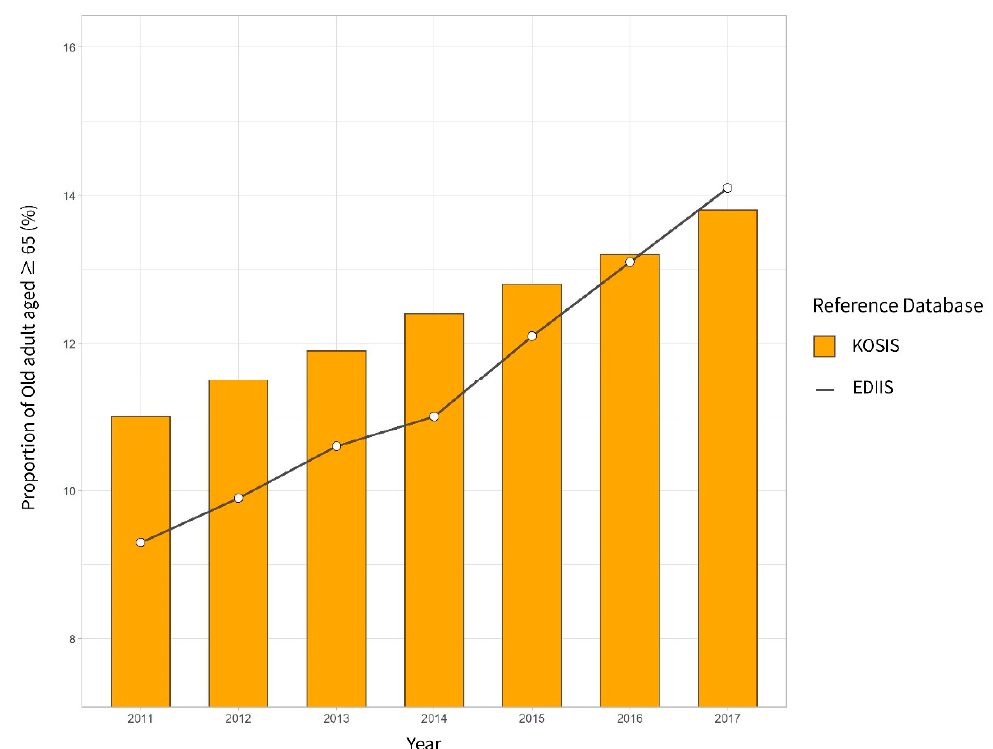
Figure 2. Proportion of older adults aged ≥ 65 years computed using the Emergency Department Based Injury In-Depth Surveillance (EDIIS) for patients with injury and the Korean Statistical Information Service (KOSIS) for the total population.